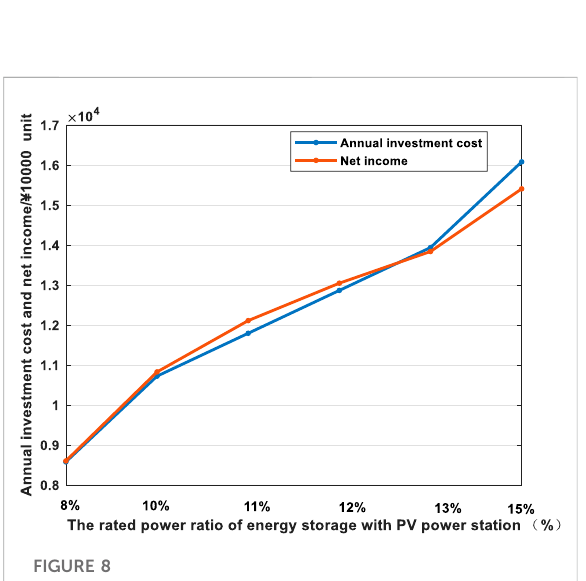
FIGURE 7 Net income of energy storage with different rated power ratios.